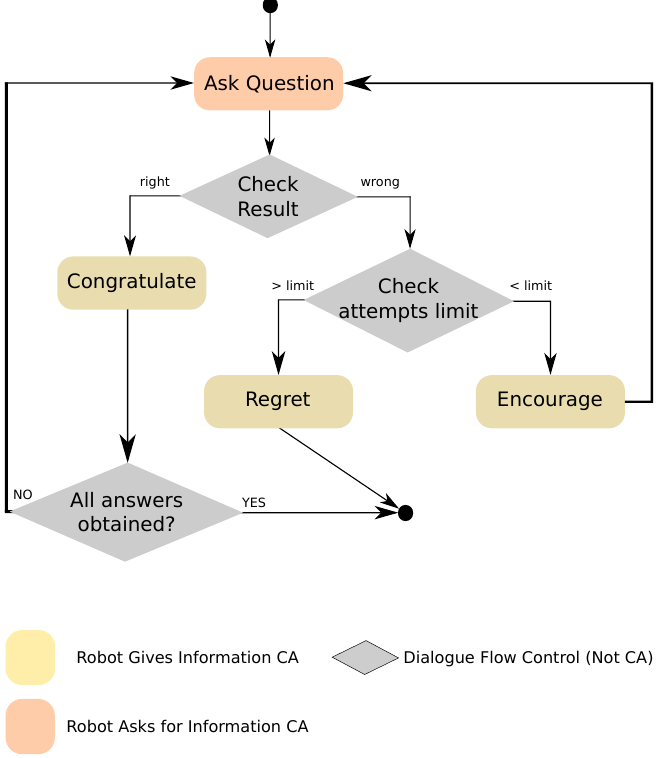
Figure 3. Flow diagram for the right–wrong question Complex Communicative Act (CCA). In this example, the CCA expects a sequence of answers in a given